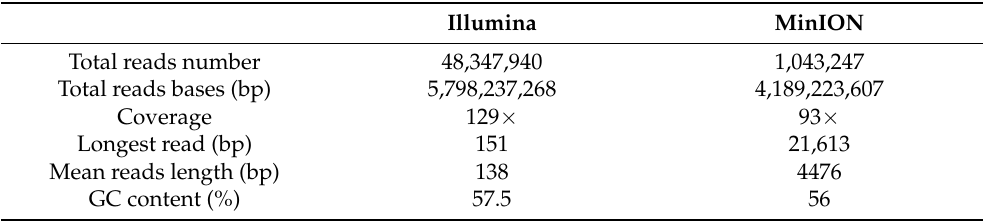
Table 1. Summary of the Illumina HiSeq and Oxford Nanopore MinION reads statistics after preprocessing